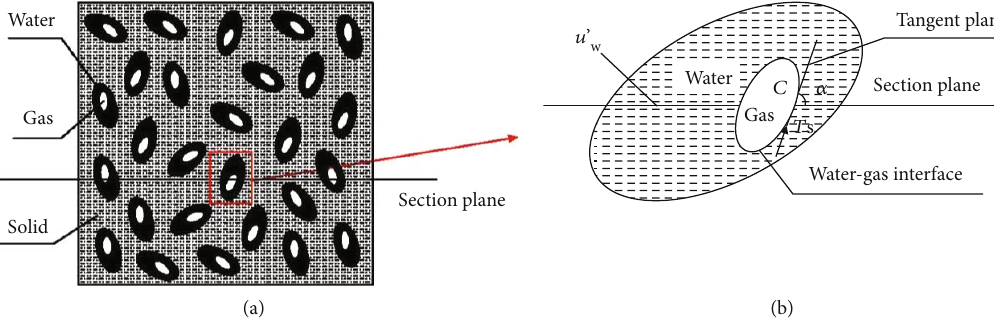
Figure 1: (a) Ideal pore structure and the distribution of water, gas, and solid; (b) angle α at point C